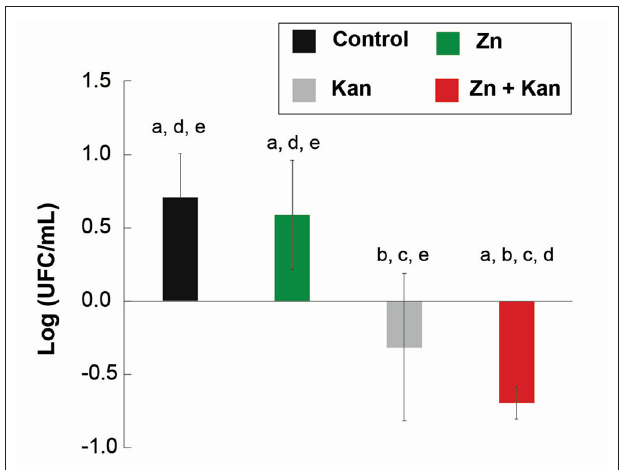
FIGURE 11 | In vivo topical antimicrobial effect of Zn-kanamycin combination in male Wistar rats. Differences from the uninfected group (baseline) of the bactericidal effect of Zn, kanamycin, and Zn-kanamycin combination (all at 0.5 MIC) in S. aureus-Kan topical infection growth. Letters above the bars indicate a significant difference ( p < 0.05) from a: uninfected, b: infected, c: Zn, d: kanamycin, and e: Zn- kanamycin groups. All experiments were tested in groups of n = 3 for 3 days. Error bars represent ±